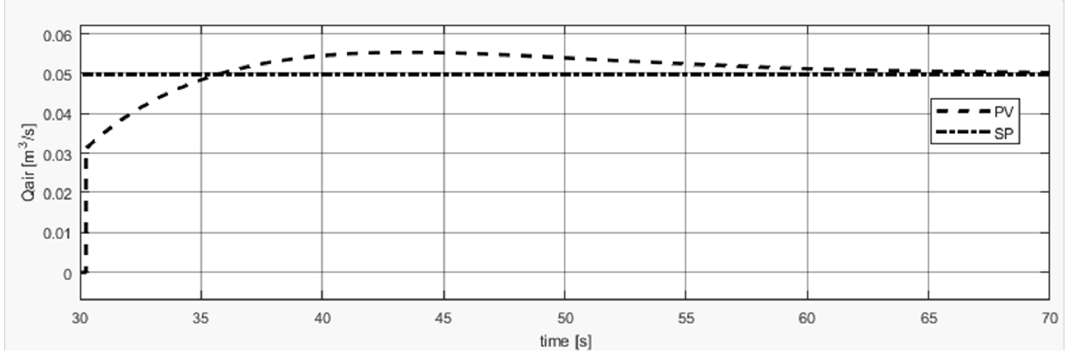
Figure 8. Step response of the second fuzzy control system.